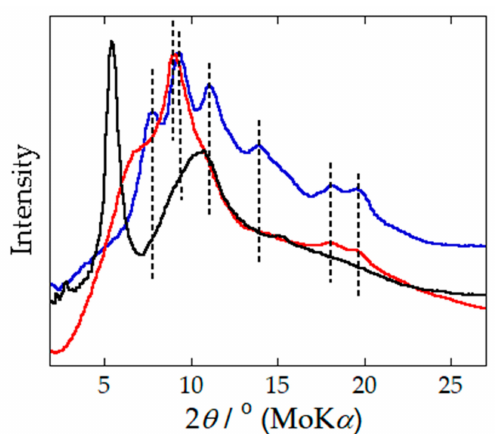
Figure 4. WAXD 2 θ -profiles of the dry SGF-gel (blue), and LF aq (black) and SGF HFIP (red) as-cast films. The black, dotted lines indicate peaks assigned to the β -sheet structure.